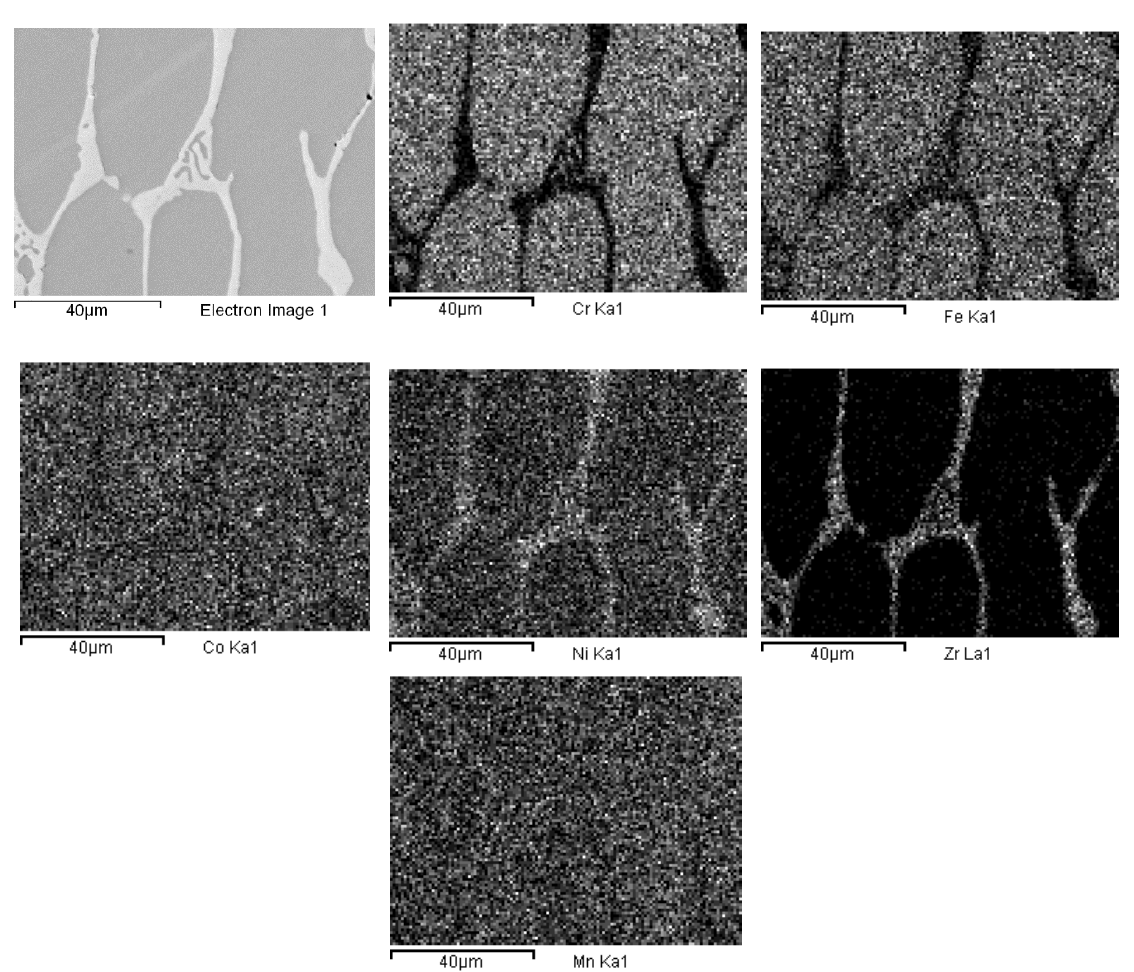
Figure 3. EDS mapping of as-cast Co 19 Cr 19 Ni 19 Fe 19 Mn 19 Zr 5 . The maps report, from left to right and top to bottom, the electron image of a portion of the specimen and the corresponding elemental distribution of Cr, Fe, Co, Ni, Zr, Mn. Electron image Co K α 1